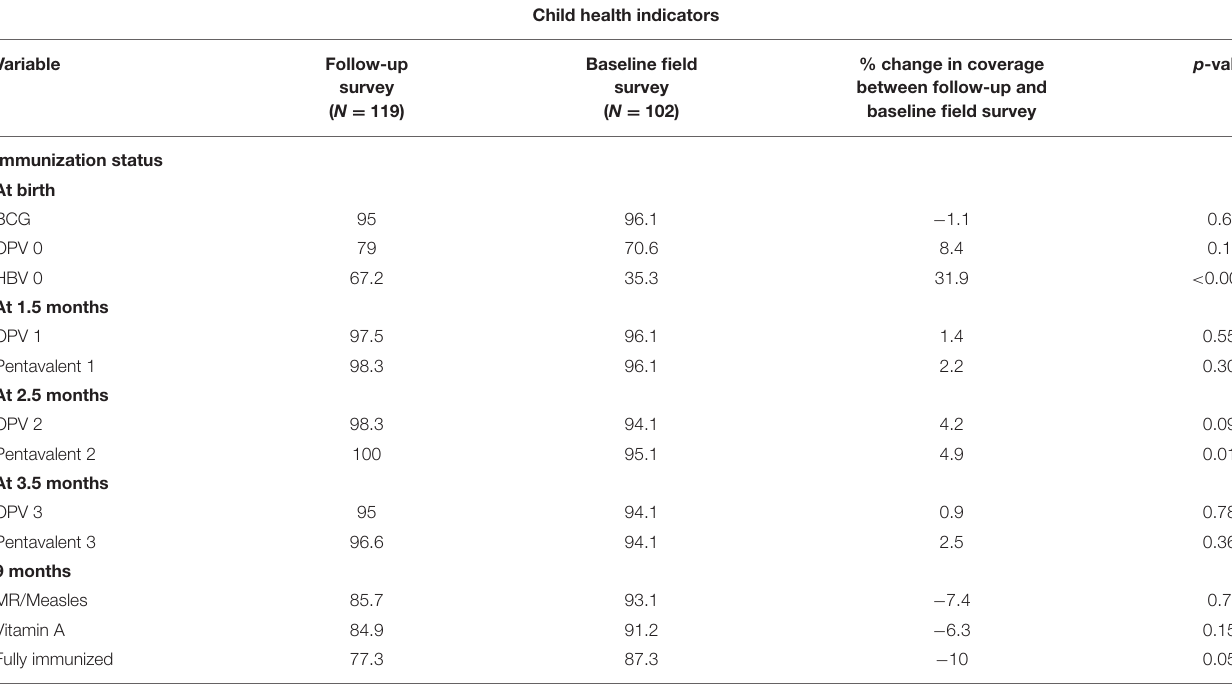
TABLE 2 | Coverage of child health indicators.